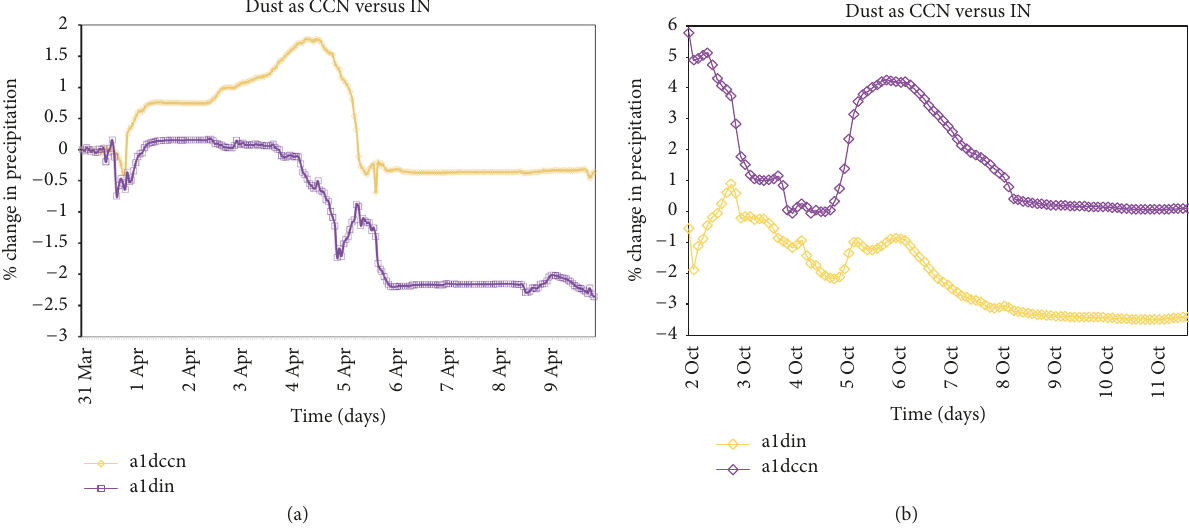
Figure 10: Plot of precipitation with no dust compared to a1dccn and a1din; yellow line: a1din; purple line: a1dccn (a). Plot of precipitation with no dust compared to dust acting only as IN and CCN; purple: a1dccn, yellow: a1din for Case Study 3 (b).